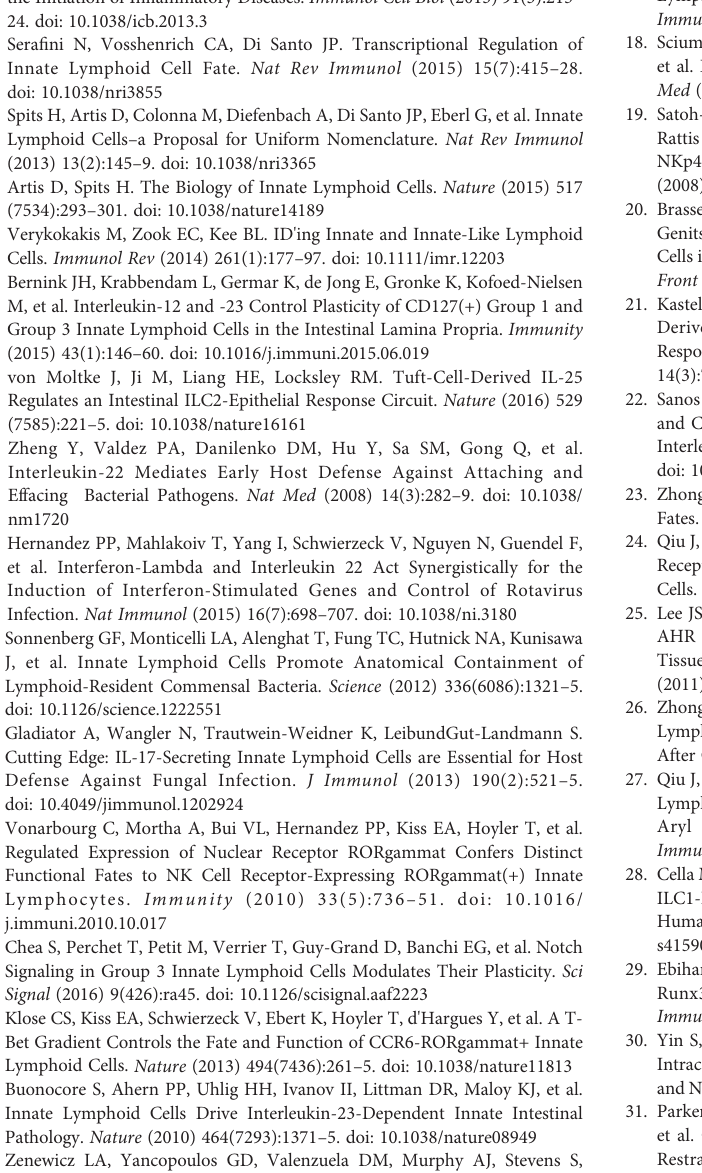
Supplementary Figure 5 | Analysis of differentially expressed genes associated with ILC3s in controls and ThPOK-de fi cient mice. (A) The numbers of the median numbers of genes that passed quality fi ltering. (B) Feature plots of expression distribution for transcription factors, cell surface markers and cytokines across pseudo-time. (B) Dot plot displaying differentially expressed genes across all clusters. Top 10 up-regulated DEGs (ranked by log fold change) of each cluster were plotted using heatmap. (C) Expression of involved key genes along the